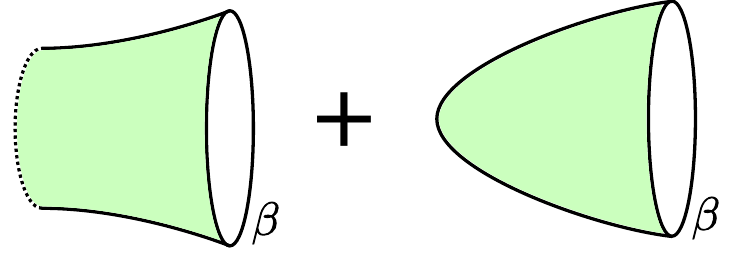
Figure 5 . Two contributions to the Euclidean gravity path integral with a boundary thermal circle of circumference β . On the left some cycle of the transverse directions contracts at the dotted line, while on the right it is the thermal circle which contracts. The contribution on the left is what is obtained from canonical quantization of gravitational effective field theory, and gives no contribution to the entropy at leading order in the gravitational coupling. The contribution on the right leads to the black hole entropy (1.1); it should be included only in effective theories which are UV-completed into a holographic